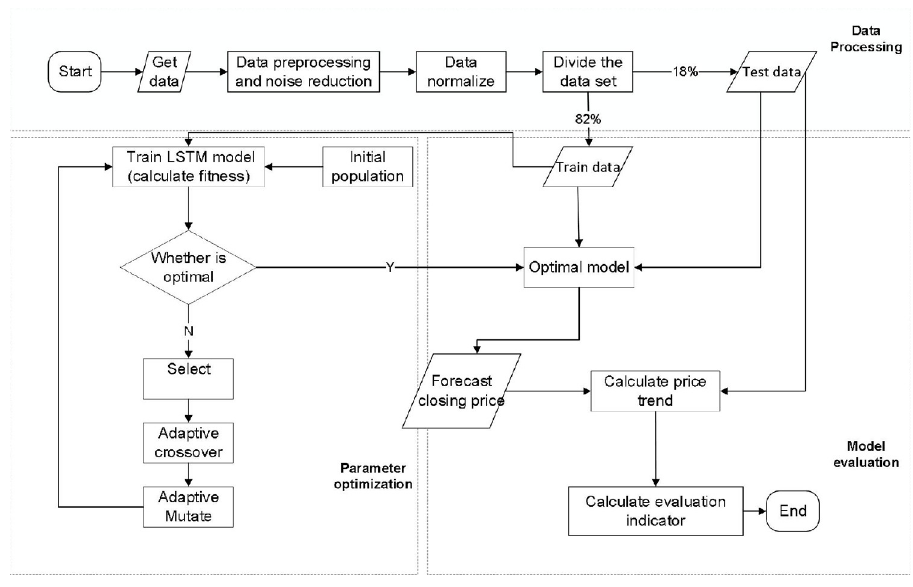
Fig 3. Flowchart of AGA-LSTM